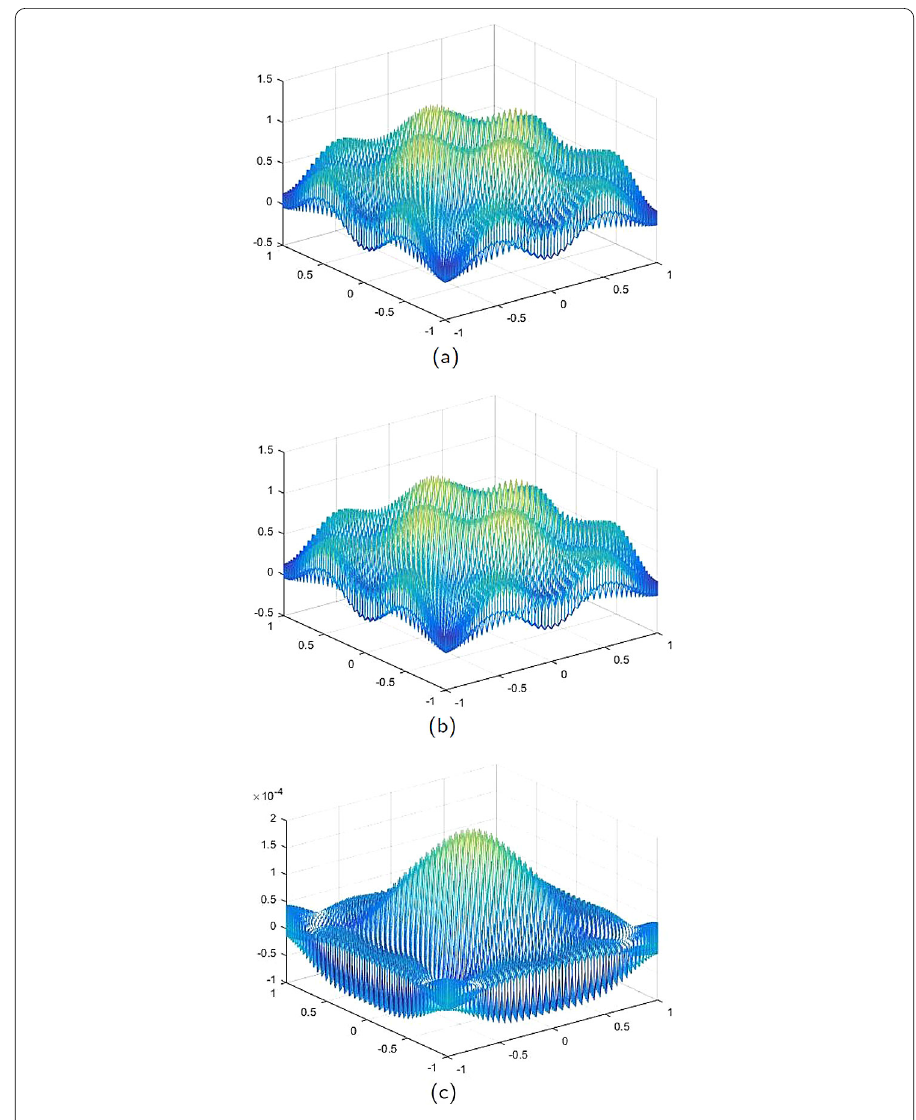
Figure 4 (a) The CNCS solution when t = 0.9. (b) The analytical solution when t = 0.9. (c) The errors between the analytical solution and CNCS solution at t =